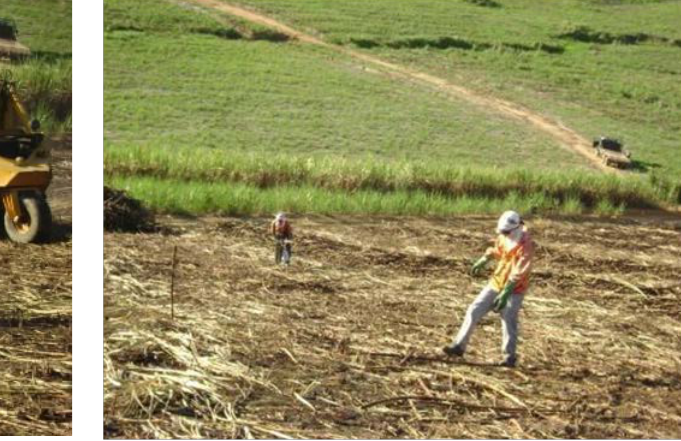
Figure 3. Collecting cut cane left for mechanized loading working activity 2)